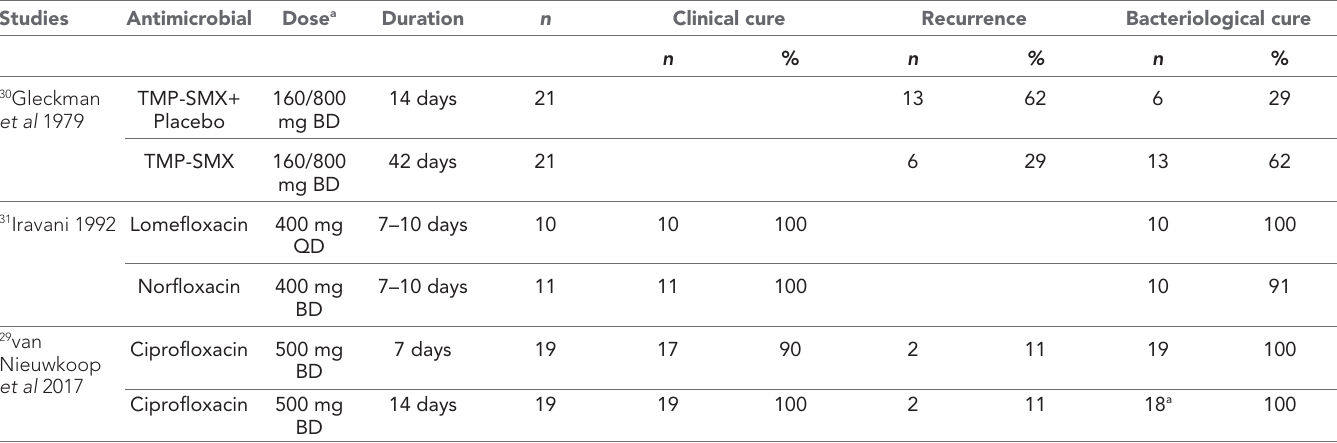
Table 2 Comparison of UTI clinical and bacteriological cure at the end of treatment, and recurrence Studies